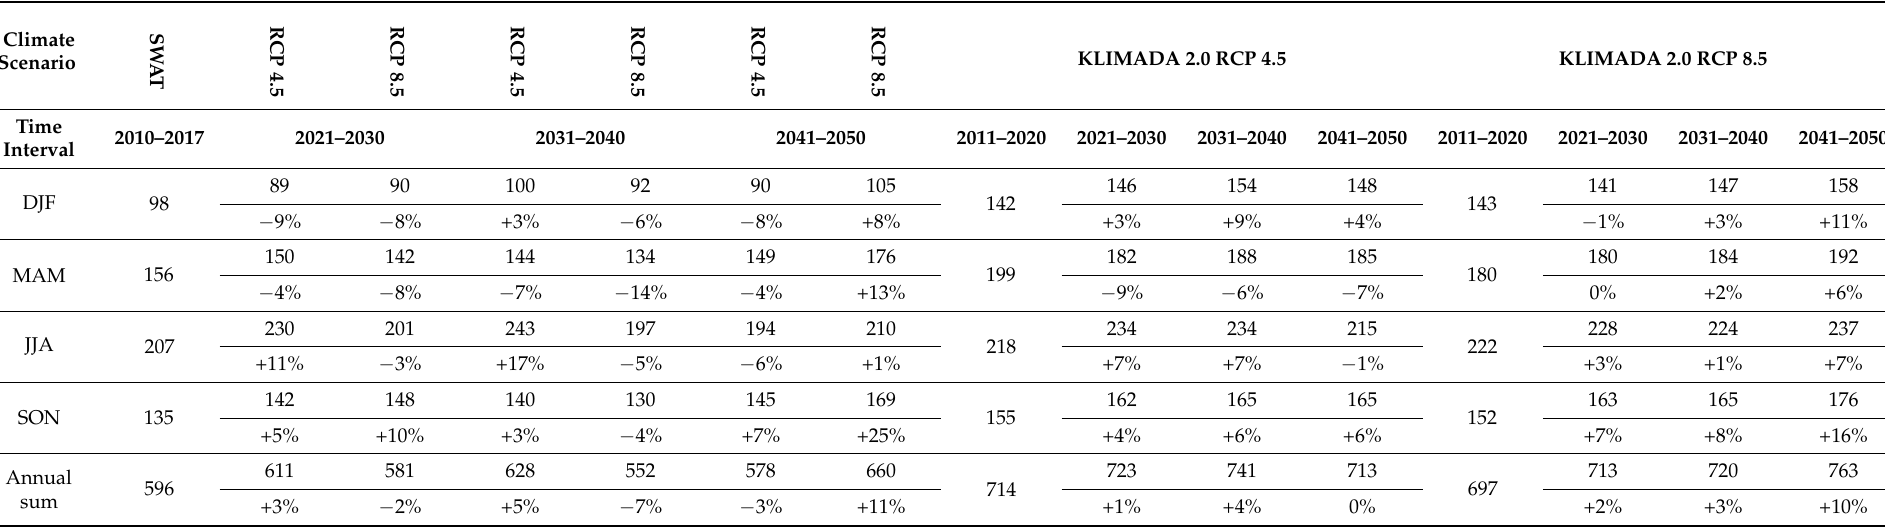
Table 11. Comparison of the average distribution of precipitation in seasons for the SWAT simulation period 2010–2017 with individual projections for the RCP